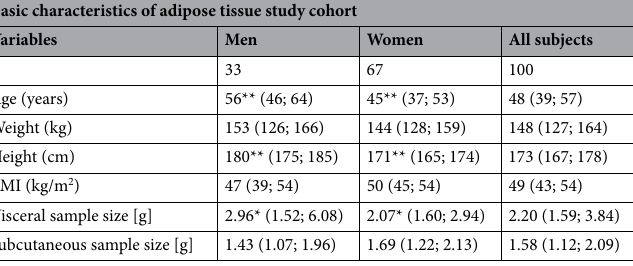
Table 4. Basic characteristics of the adipose tissue study cohort. Values are shown as median (25th and 75th percentiles); Mann–Whitney-U-test (* p < 0.05; ** p < 0.01) (statistical significance p < 0.05).